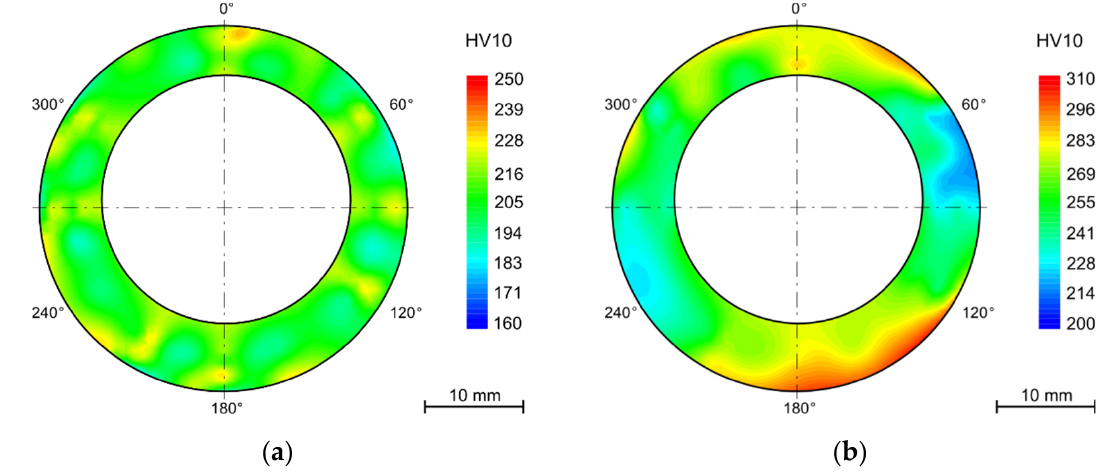
Figure 7. Heat exposure in powerplant 10 484 h ( a ) solution annealing after bending (1,130°C/15 min/water); ( b ) without HT.